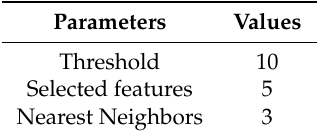
Table 8. Relief-F features for UMass Electric Dataset.